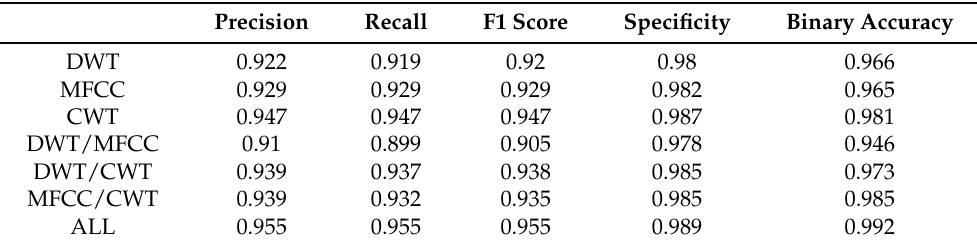
Figure 8. Models’ performance: The graph shows the precision, recall, F1 score, specificity and binary accuracy achieved by each proposed model: the independent networks, a combination of pairs of them and the complete model based on Table 2. Table 2. Comparative table between precision, recall, F1 score and specificity achieved by each proposed model: the independent networks, a combination of pairs of them and the complete model. Precision